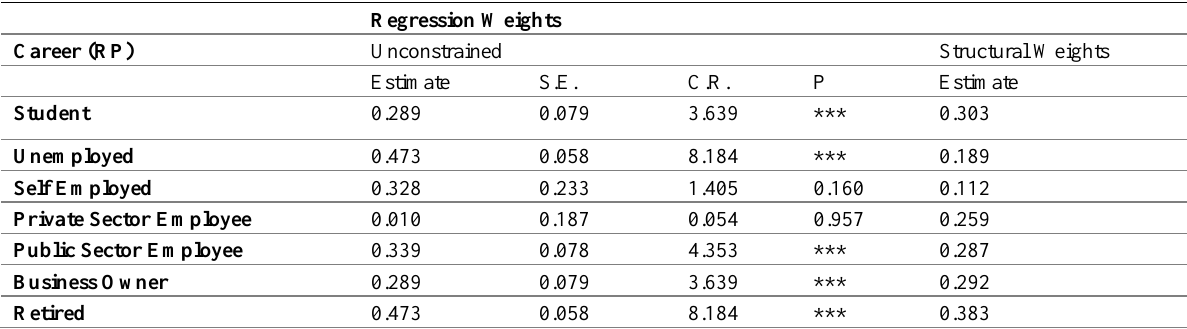
Table 11: Regression weights of the relationship among career of the consumer, return process experience post-purchase regret